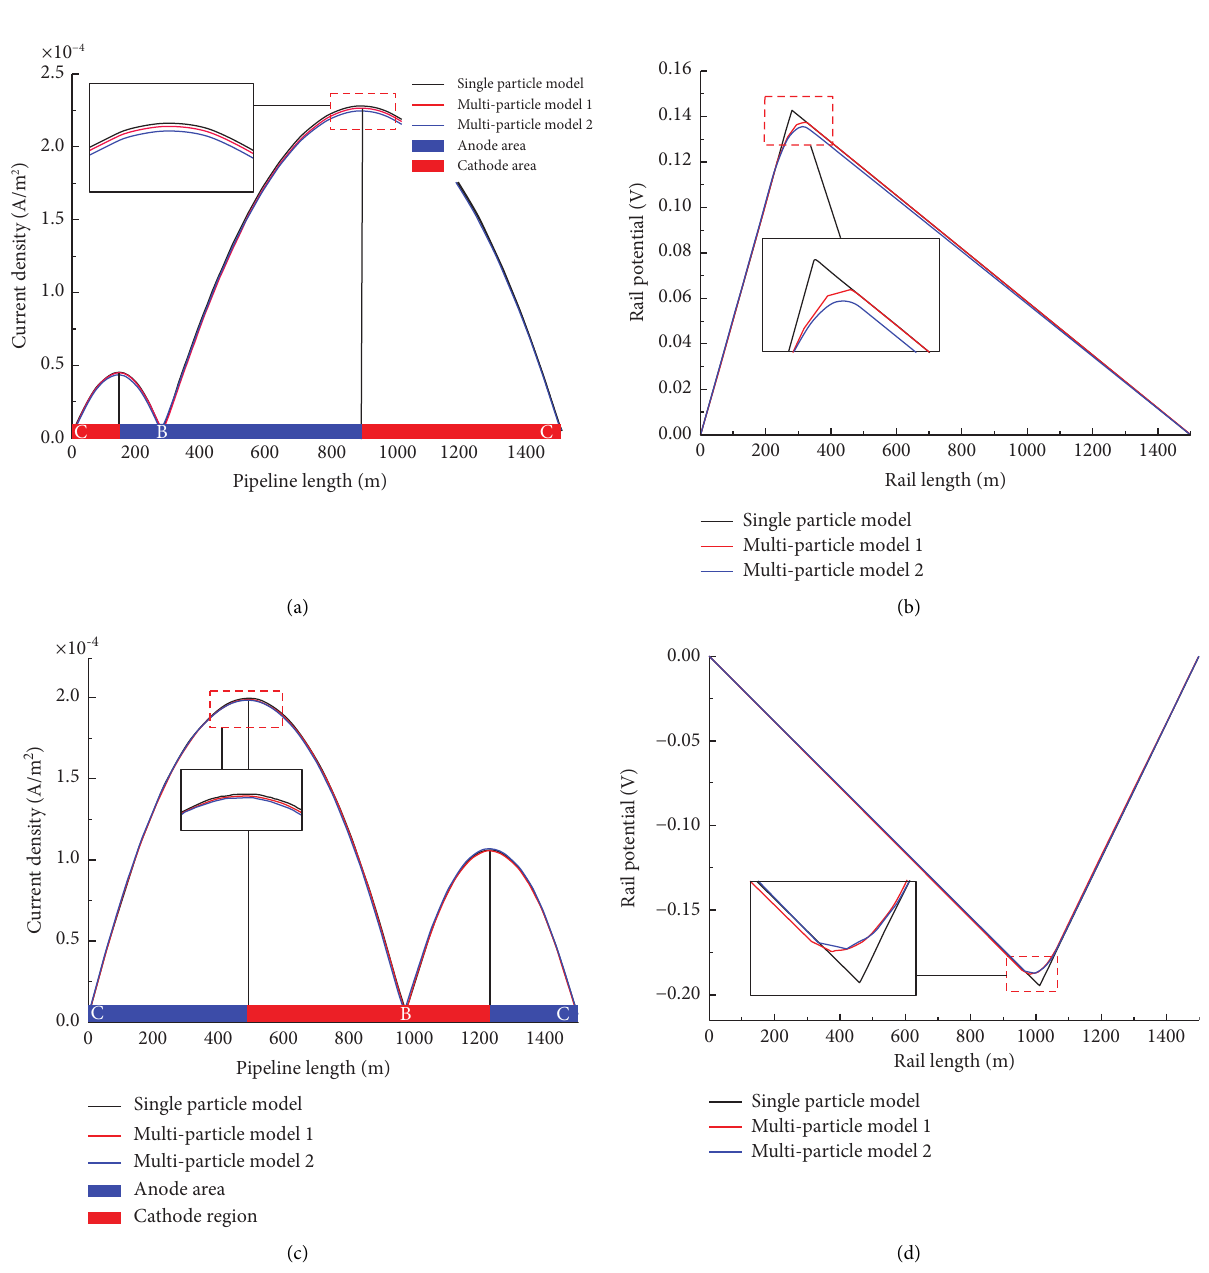
Figure 6: Analysis of the influence of each model on stray current and rail voltage. (a) Pipeline current density ( t � 20s). (b) Rail potential ( t � 20s). (c) Pipeline current density ( t � 55s). (d) Rail potential ( t �